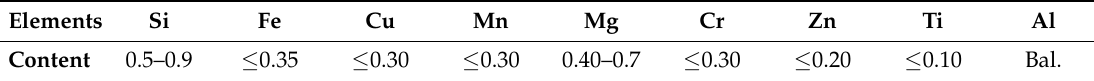
Table 1. Chemical composition of the commercial 6005A-T6 alloy at manufacture (wt %).